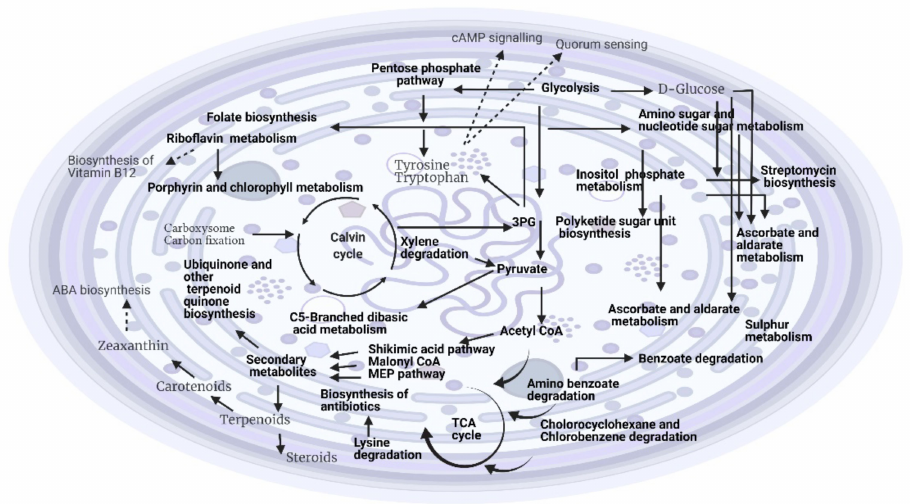
Figure 3. Cellular model representing the effects of temperature on the metabolic activities of Hapalosiphon sp. (MRB 220) based on metabolic profiling. The metabolites corresponding to pathways shown in the grey color were partially identified. Created with BioRender.com (accessed on 4 August